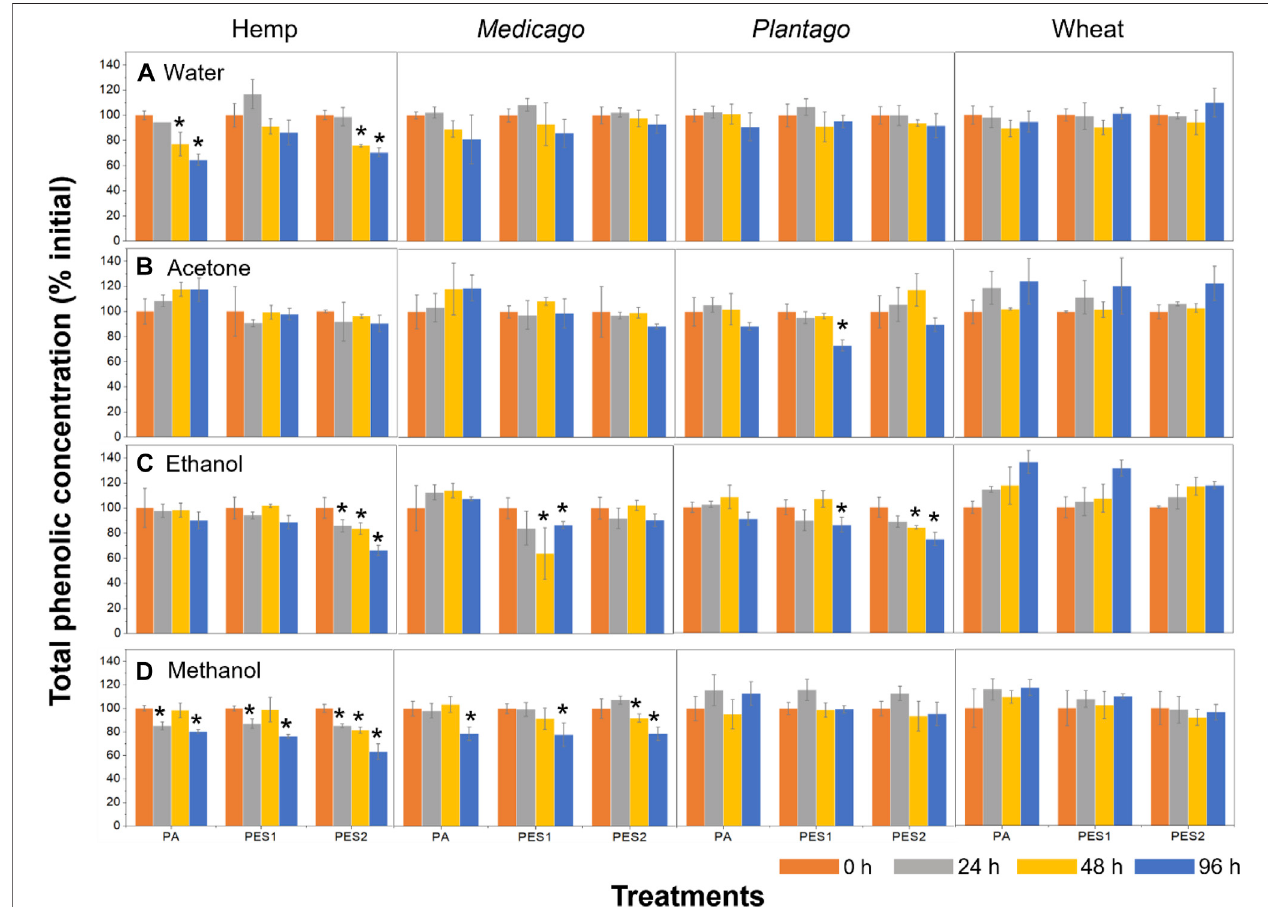
FIGURE 4 | Total phenolic concentrations in each plant litter with each MF addition. Each plant litter extract was prepared using (A) deionized water (B) 80% acetone (C) 80% ethanol, and (D) 80% methanol, and each extract was shaken with each MF for 96 h. The total phenolic concentrations was measured at each time interval (0, 24, 48, and 96 h). The asterisks (*) indicate signi fi cant ( p < 0.05) differences compared to the initial concentrations (0 h) of each treatment. Tukey ’ s multiple comparison tests were used after one-way analyses of variance.